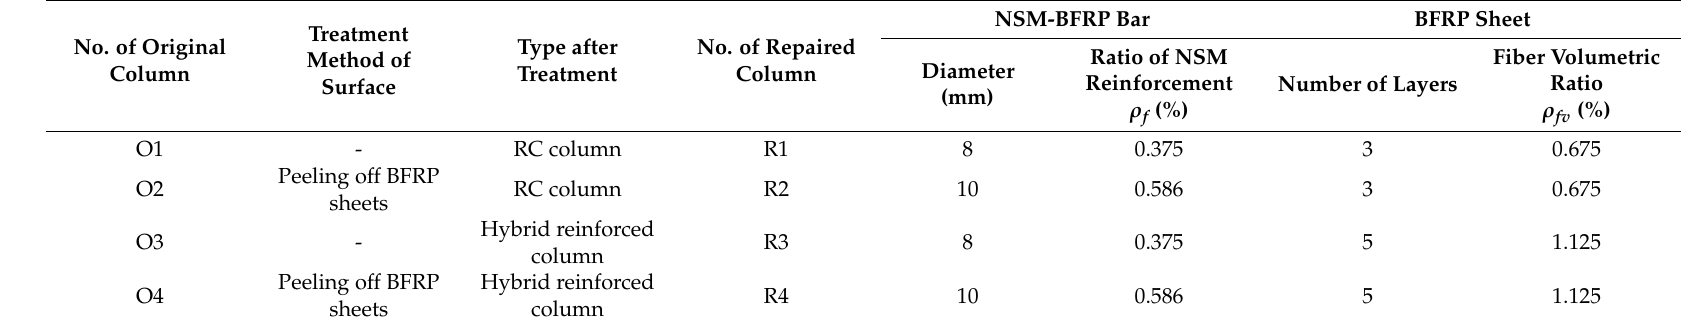
Table 2. The repairing program using the BFRP bars-sheets composite repair